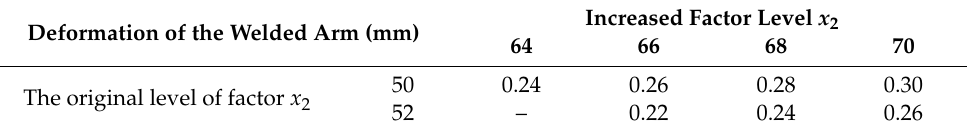
Table 8. Statistically significant differences in the arm length at different levels of factor x 2 .